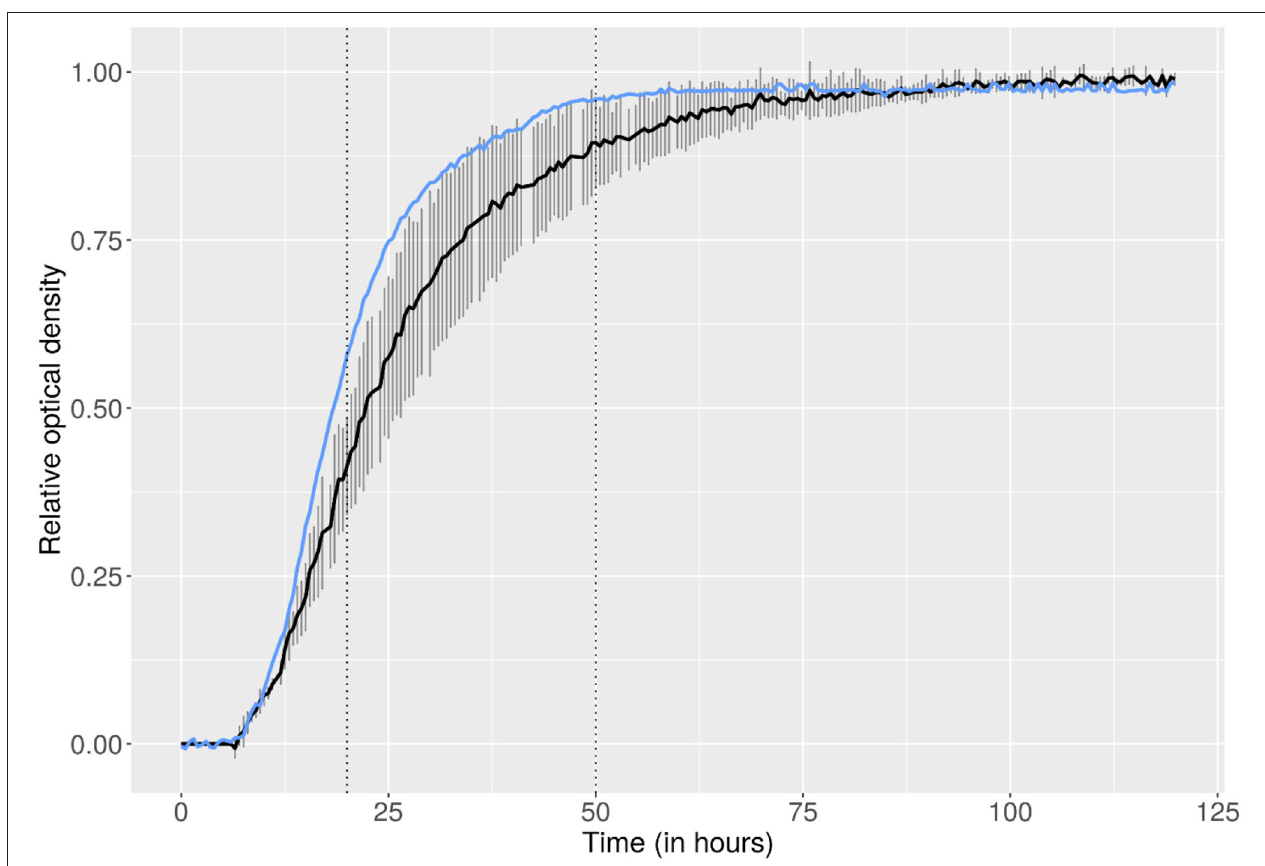
FIGURE 2 | Growth curves (initial 120h shown) for C. sphaerospermum cultivated on solid medium (PDA), depicted by means of connected data points of relative optical densities. While the on-orbit experiment (blue) was a single run, the ground control growth experiment (black) was conducted three times (two replicates in each of the three runs; t 0 was normalized based on the onset of exponential growth of the flight experiment). Error bars show the standard deviation between the three separate runs of the ground